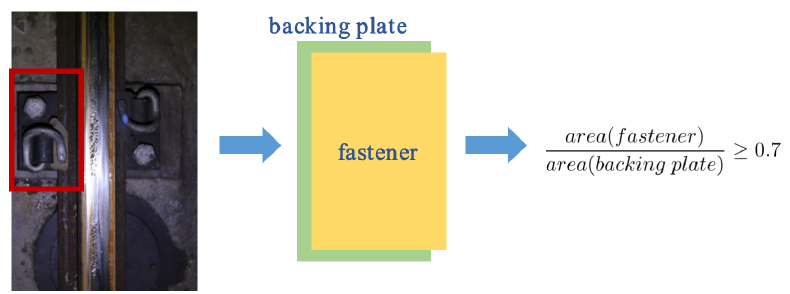
Figure 5. Sketch map of the overlap between the fastener area and the backing plate